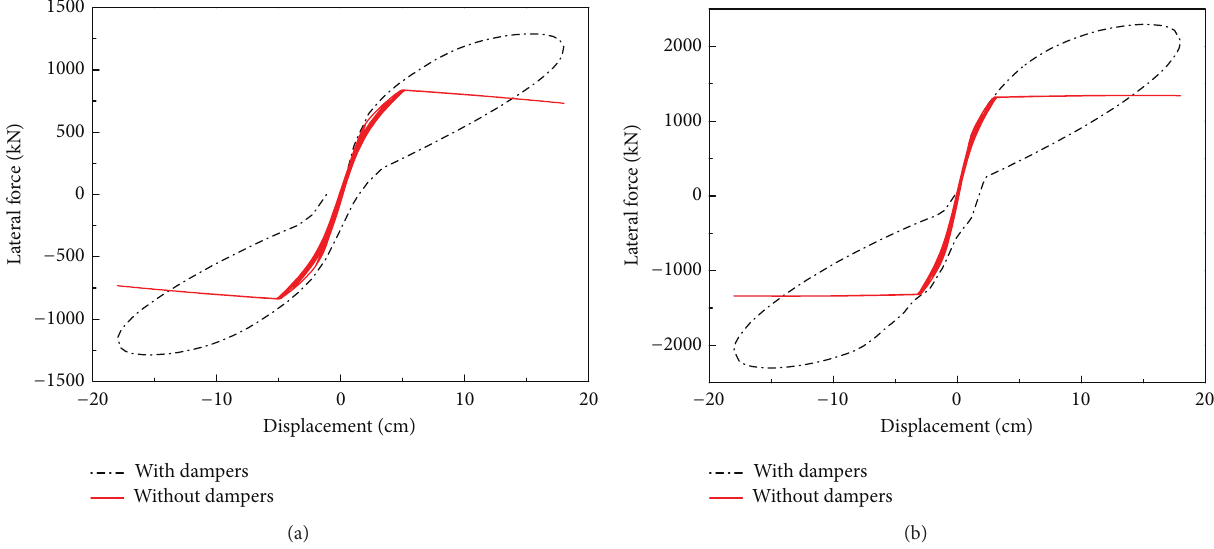
Figure 5: Hysteretic curves of the bridge pier: (a) weak axis; (b) strong axis.